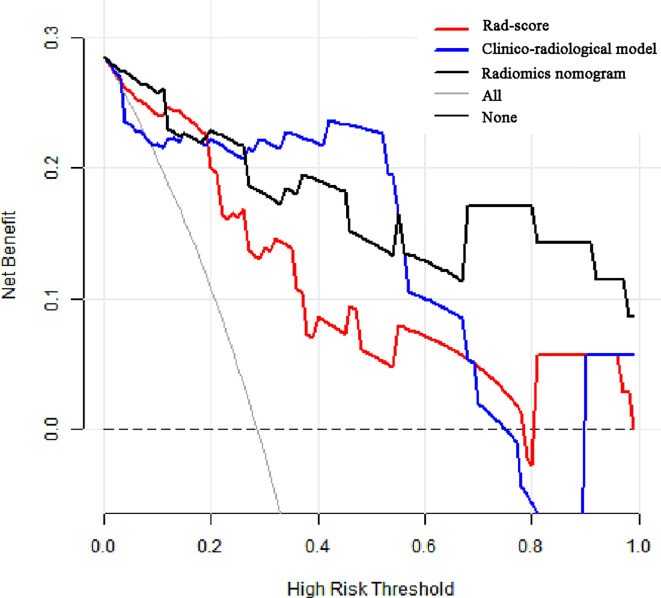
Decision curve analysis (DCA) for the prediction models in the validation cohort. The y-axis represents the net benefits, while the x-axis represents the threshold probability. The red line represents the Rad-score. The blue line represents the clinico-radiological model. The black line represents the radiomics nomogram. The gray line represents the assumption that all patients were included in benign group. The dotted black line represents the assumption that all patients were included in malignant group. The decision curve shows that radiomics nomogram can add more net benefit than “none” or “all” treatment with the threshold probability range from 0 to 1.0.